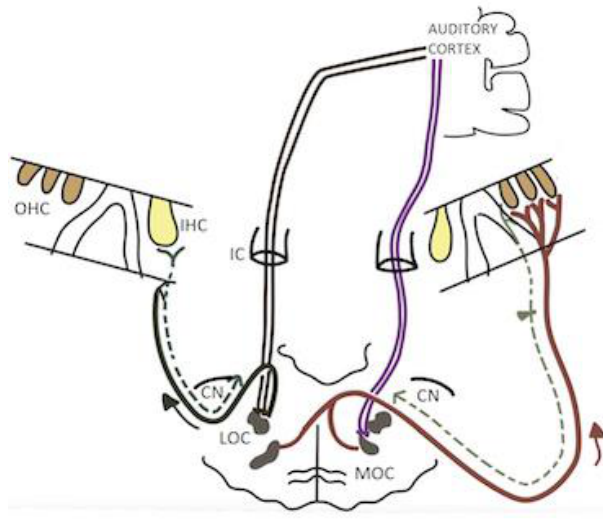
Figure 1. Simplified representation of the olivocochlear system.